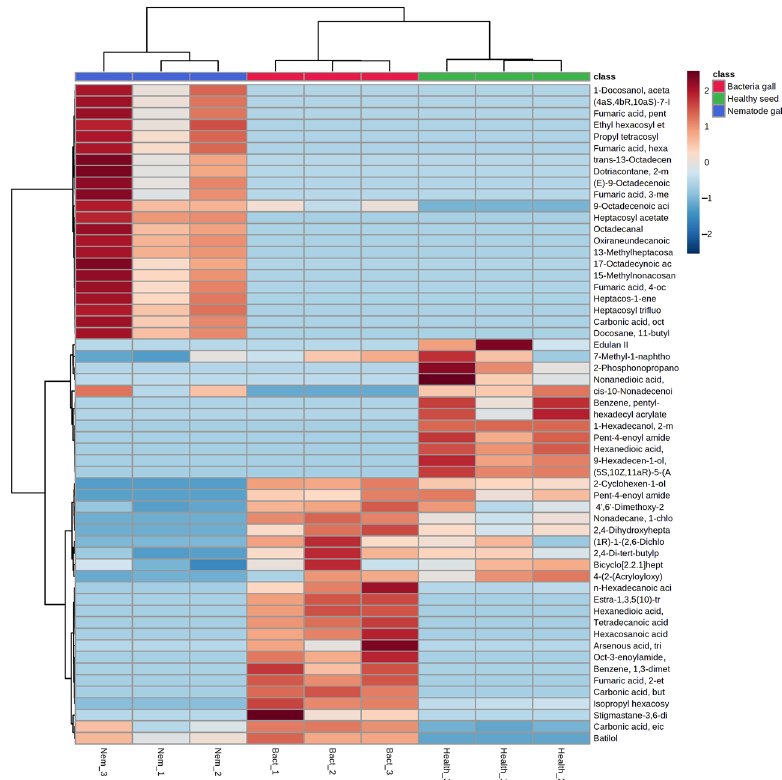
Figure 4. Heat map of metabolites obtained from nematode gall and bacteria gall in comparison to healthy seed of ryegrass. The three similarly colored columns represent biological replicates of each treatment. Red indicates Z-scores > 0 and blue indicates Z-scores < 0. The saturation threshold is set at ±2 (Z-score − 2 to +2 representing low to high values).